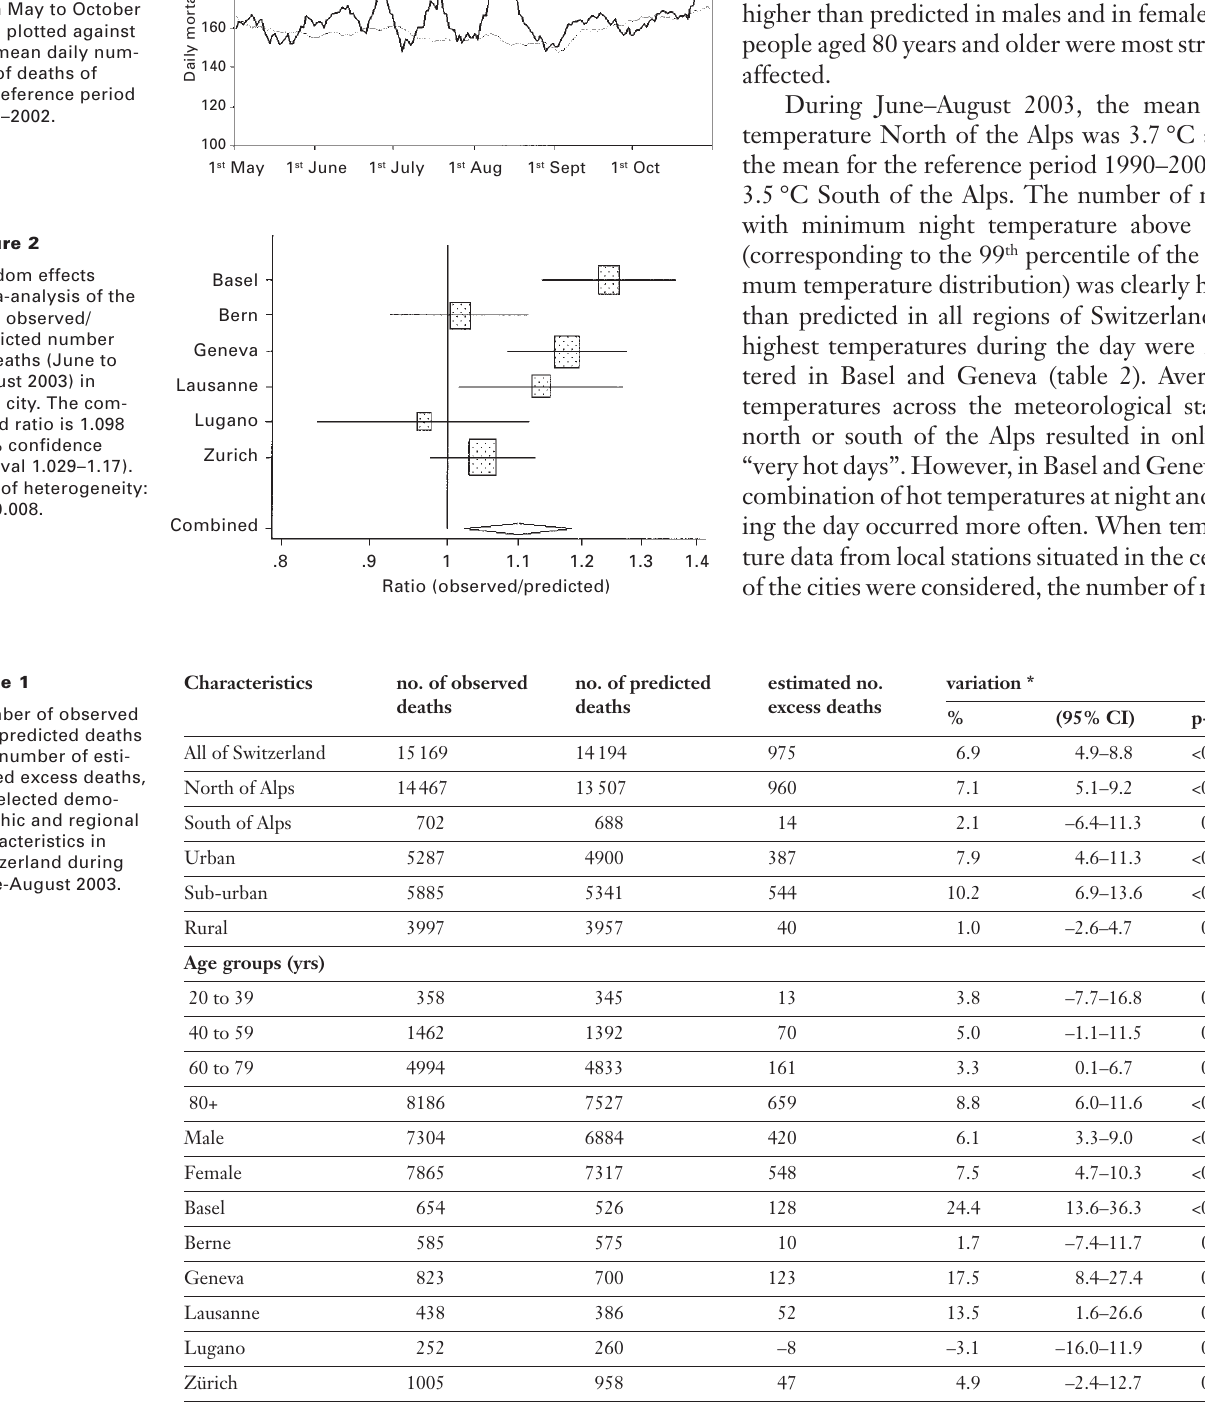
Daily total mortality (7 day moving aver-